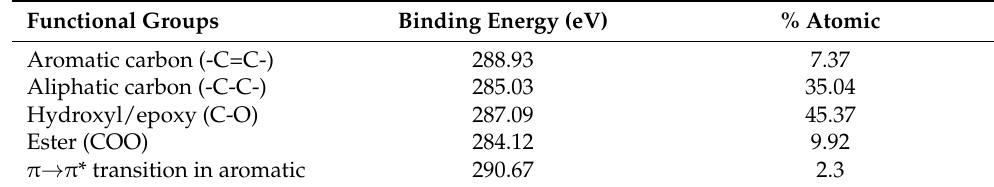
Table 2. Analysis of C1s scan showing the chemical groups in GO-Au. Functional Groups Binding Energy (eV) %